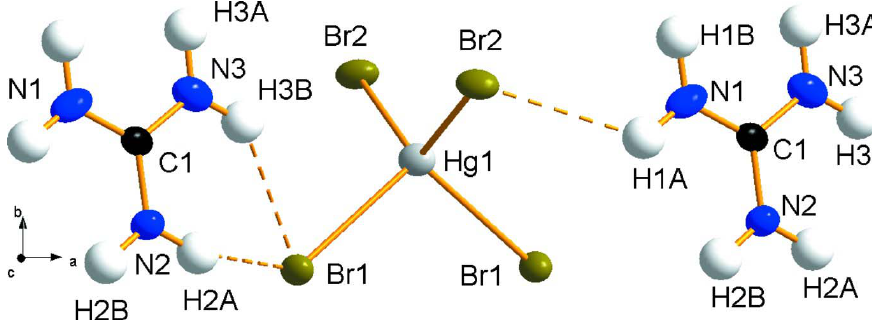
Figure 1 Molecular structure of (I), showing the atom labeling scheme. The displacement ellipsoids are drawn at the 50% probability level. The H atoms are represented as small spheres of arbitrary radii.